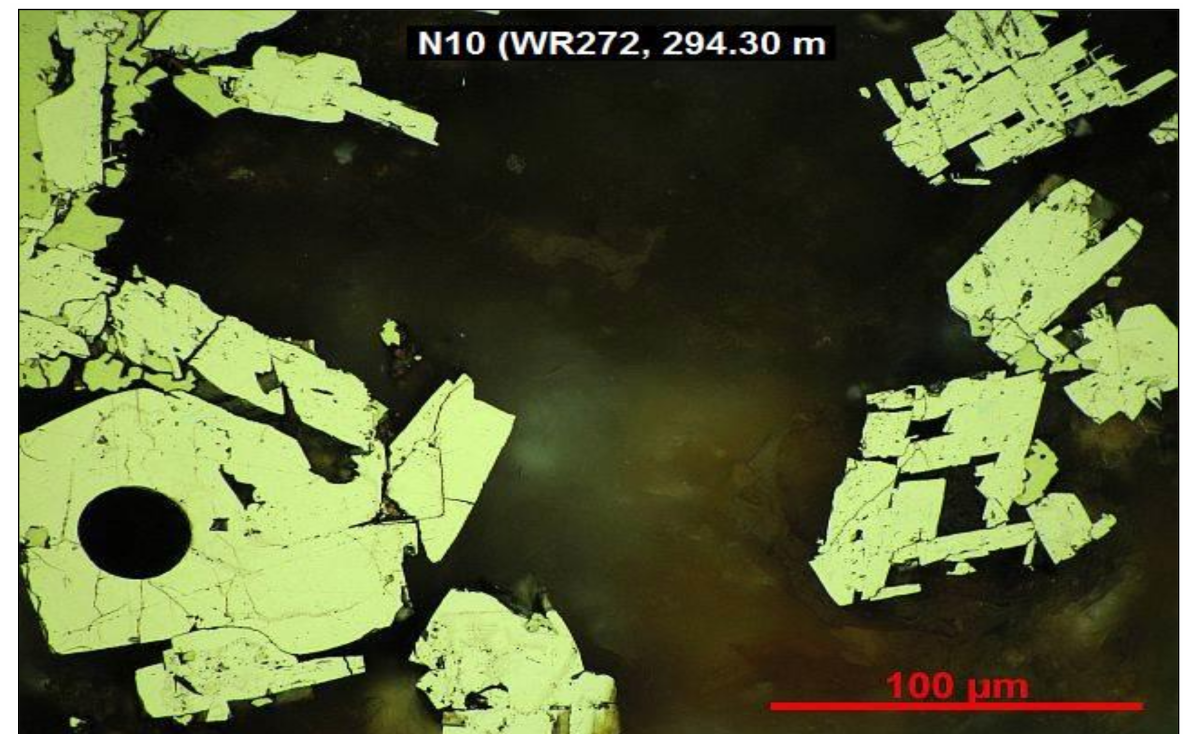
Figure 10. Photomicrograph of pyrite crystals from sample N10 (i.e., drill hole = WR272, depth = 294.30 m). Pyrites in sample N10 have platy, prismatic and lamellar textures. The textures indicate a pseudomorphic replacement of a hexagonal mineral, most likely hematite. Note that the pyrite is overgrown and is replaced by late